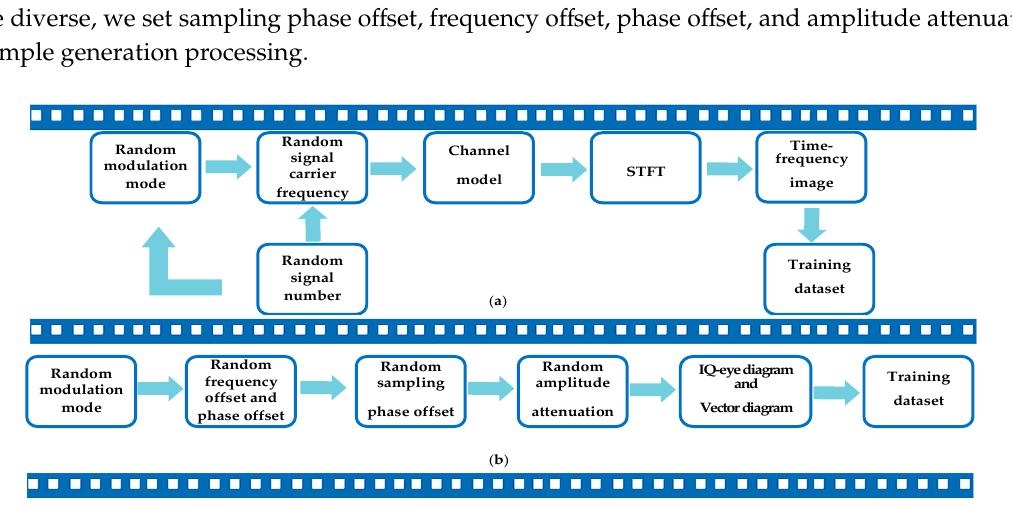
Im Figure 4. the enhancement processing of the dataset. For modulation recognition, traditional eye diagram and vector diagram are binary images, which do not consider the signal aggregation degree at a particular location. Hence, we consider the signal aggregation degree and enhance the traditional eye diagram and vector diagram. Figure 4 presents the enhancement processing of the dataset. In our initial research, since CNNs are insensitive to edge information, the signal amplitude is quantified between [ − 1.05, 105] by 128 after normalizing the amplitude. Furthermore, the parameter settings are obtained by experiments. For example, we choose 800 symbols and 4 symbols as a waveform group to generate the eye diagram and the vector diagram, and related experiments will also be described in detail in subsequent